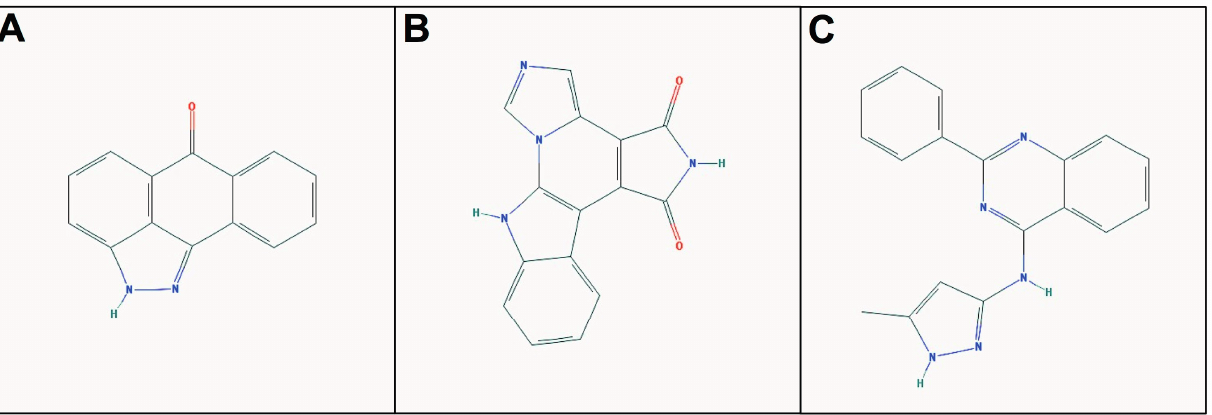
Figure 3. Two dimensional structure of the best candidate compounds. ( A ) JNK Inhibitor II; ( B ) Isogranulatimide; ( C ) GSK-3 Inhibitor